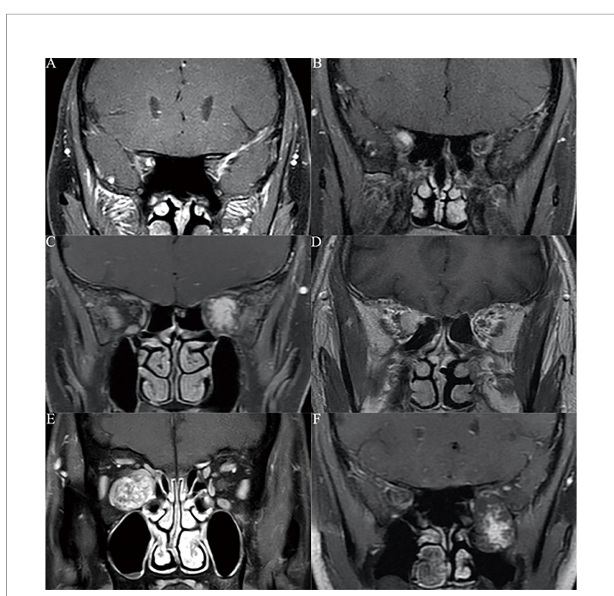
FIGURE 1 | According to optic nerve MRI and intraoperative con fi rmation, we found the common location classi fi cation of orbital cavernous hemangioma. (A) MRI of optic nerve showed the tumor is located under the optic nerve sheath in the orbital apex area. (B) MRI of optic nerve showed the tumor is located in the common tendon ring of the orbital apex region. (C) MRI of optic nerve showed the tumor is located inside the muscle cone of the orbit. (D) MRI of optic nerve showed the tumor is located outside the muscle cone of the orbit. (E) MRI of optic nerve showed the tumor involved both the inside and outside communication region of the muscle cone. (F) MRI of optic nerve showed the tumor involved both the inside and outside communication region of the orbit. On all contrast-enhanced MRI images, we can see that cavernous hemangioma varies in size according to its location in the orbit, showing homogeneous or patchy